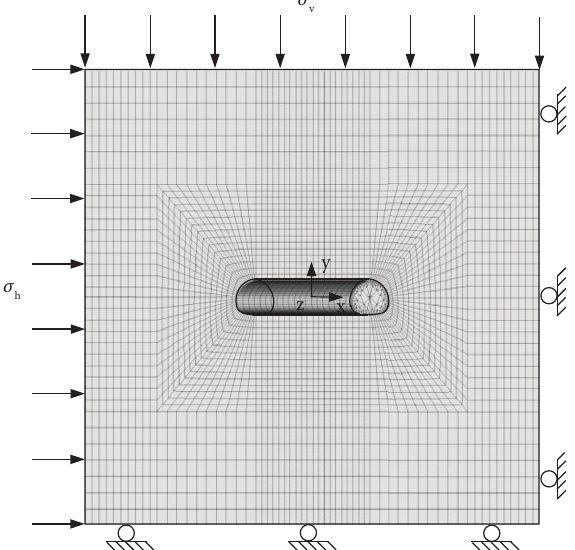
Figure 6: x - y section view of the meshed model at middle with specific boundaries and loading conditions ( φ � 20 ° ).